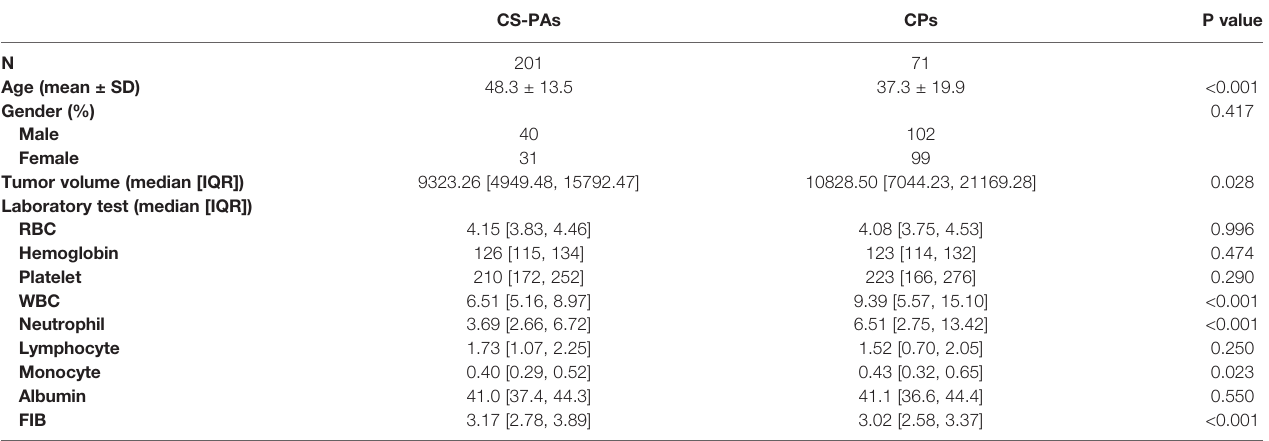
TABLE 1 | Baseline characteristics of patients with CS-PAs and